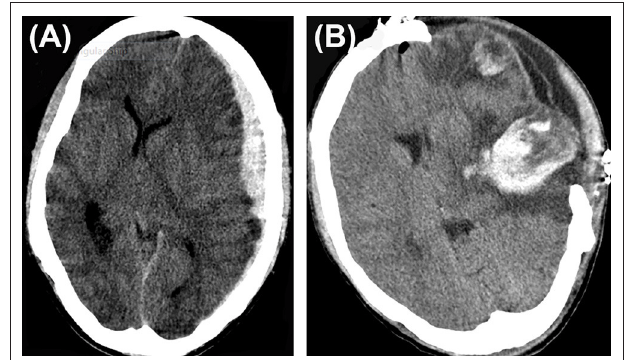
FIGURE 1 | Hematoma expansion. (A) A case of traumatic brain injury depicting subdural hematoma (B) , hematoma expansion, and subdural collection post craniectomy.